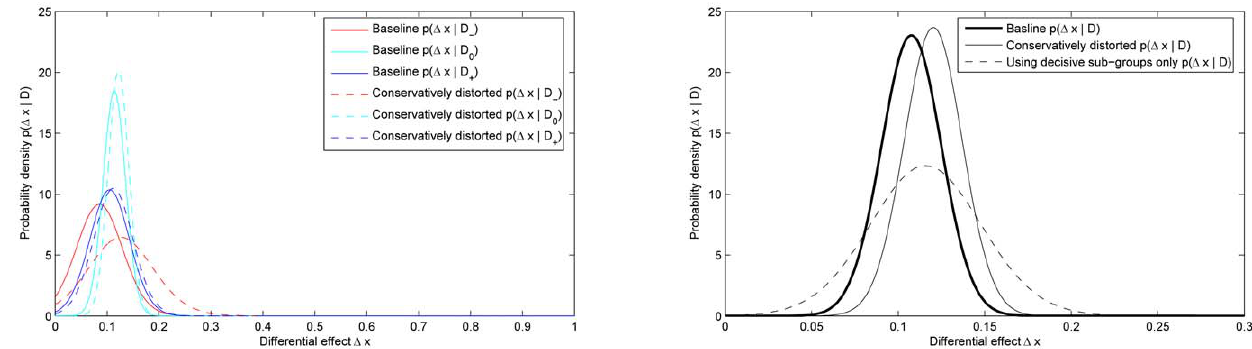
Figure 6. Experiment 2. (a) Posteriors for the differential effect treatment D x computed using the data D g of each experimental sub-group comprising control and treatment individuals matched by their feedback. (b) Posterior for the differential effect treatment D x computed using all available data D ( ~ | g D g ).